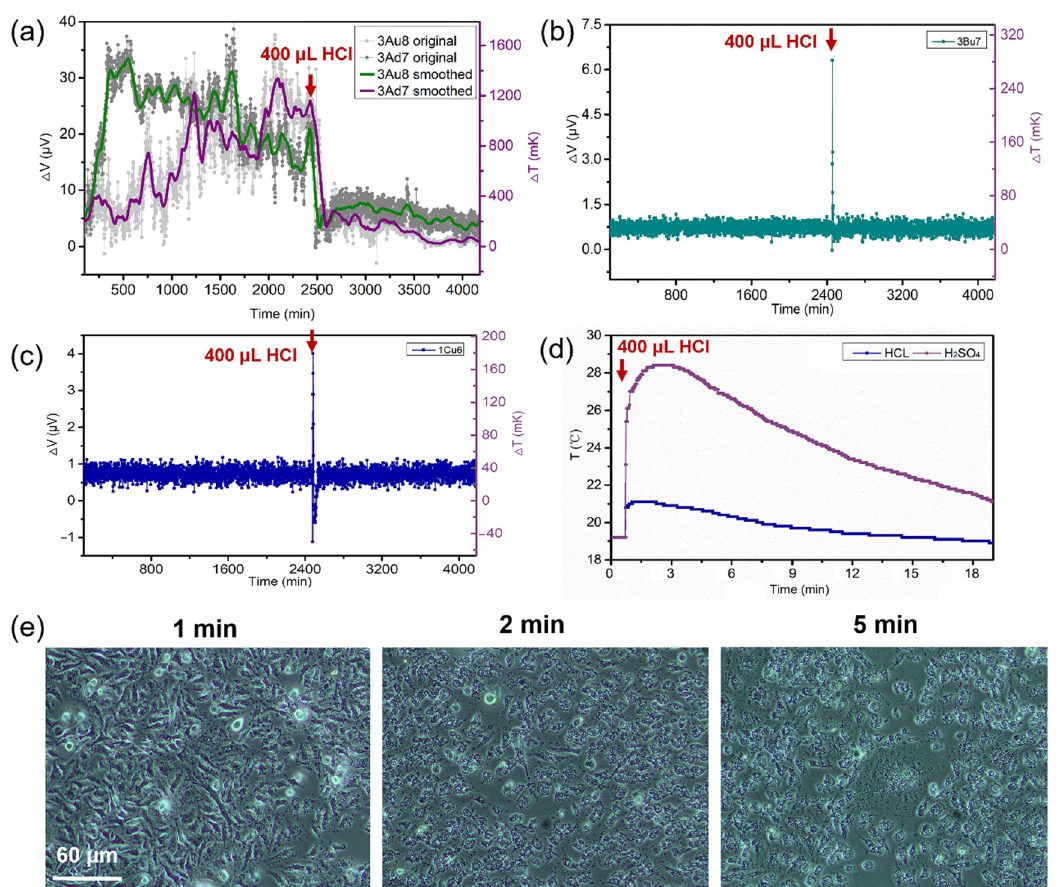
Figure 5. The temperatures of the HeLa cells drop sharply upon the addition of a lethal fluid (the red arrows represents the moment when concentrated HCl is injected into the medium). ( a ) Two typical curves showing the temperature changes caused by the deaths of the HeLa cells due to the addition of concentrated HCl. ( b ) The control group shows no obvious temperature drop in the HeLa cells on the Si 3 N 4 /Si/Si 3 N 4 substrate when subjected to concentrated HCl. ( c ) The blank control group containing the culture medium without HeLa cells also shows no obvious temperature drop after the injection of concentrated HCl. ( d ) Temperature changes of the culture medium caused by the exothermic effects of concentrated H 2 SO 4 and of concentrated HCl. ( e ) The morphology of HeLa cells at the moments 1 min, 2 min, and 5 min after the introduction of concentrated HCl.